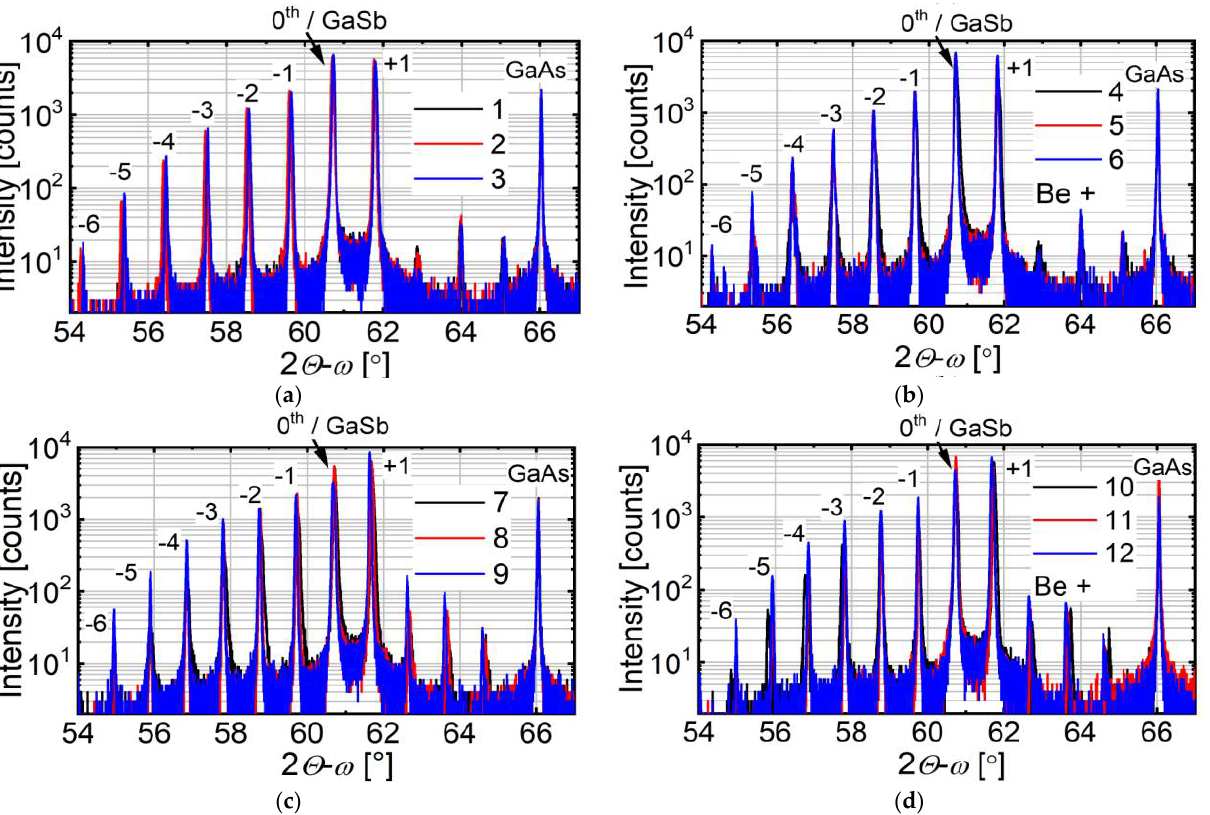
Figure 2. HRXRD spectra: ( a ) samples 1, 2, 3; ( b ) samples 4, 5, 6; ( c ) samples 7, 8, 9; ( d ) samples 10, 11, 12.